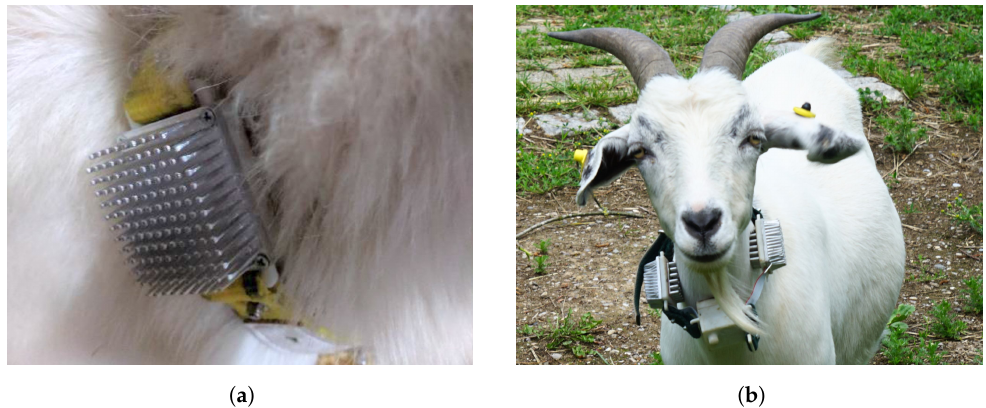
Figure 9. Side-by-side: Collar attached to the animal’s fur in winter and late spring. As the goat lost its fur, the thermal connection is not optimal any more in the field test in spring. ( a ) Prototype of the thermal housing to determine the right fin length for an optimal penetration into the goat’s fur—done in winter. ( b ) Goat with the tracker at the end of field-test in late spring. One housing is detached from the